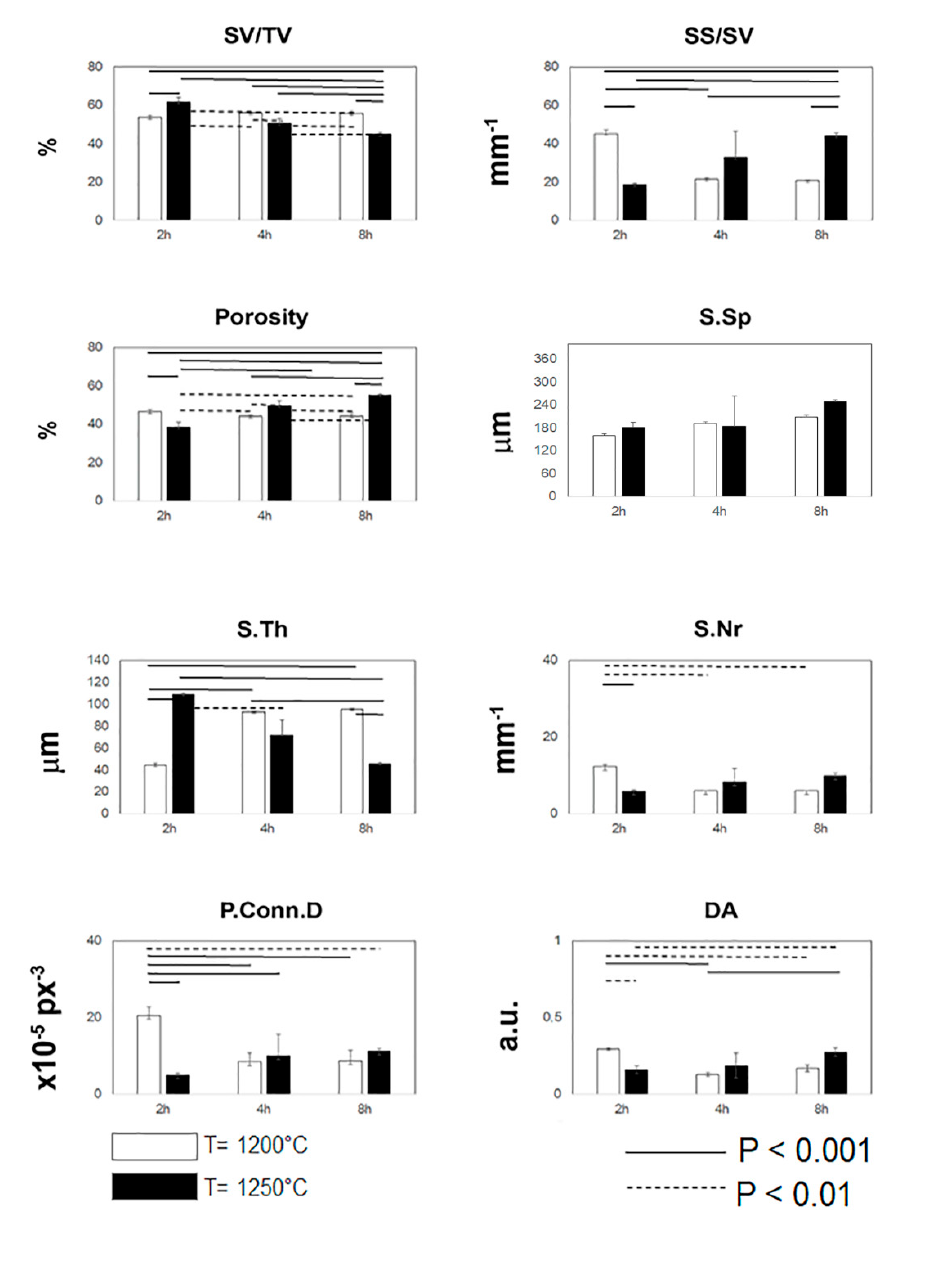
Figure 2. Morphometric 3D data, as measured in the different samples before compressive tests by microCT. Histograms graphically depict morphometric parameters as a function of the selected groups of samples. Mean and standard deviation data are indicated for each group of the study. Statistically significant differences between groups are highlighted (dashed line: p < 0.01; solid line: p < 0.001).